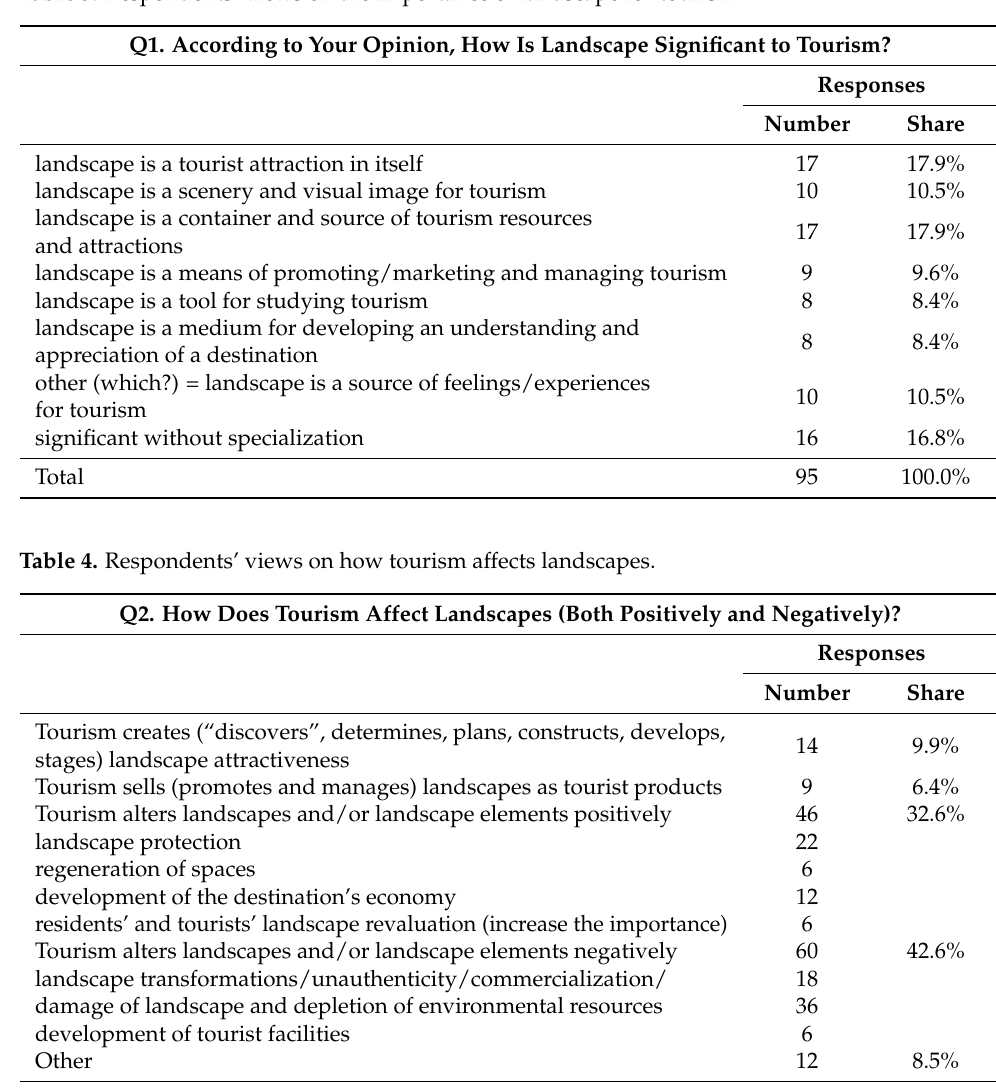
Table 3. Respondents’ views on the importance of landscape for tourism.